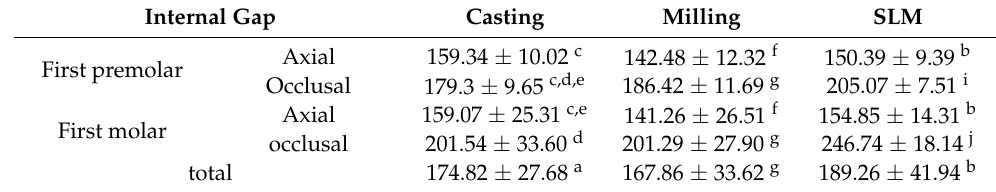
Table 3. Internal gaps of a 3-unit bridge in casting, milling, SLM groups after the firing cycle process. Internal Gap Casting Milling SLM Axial First premolar